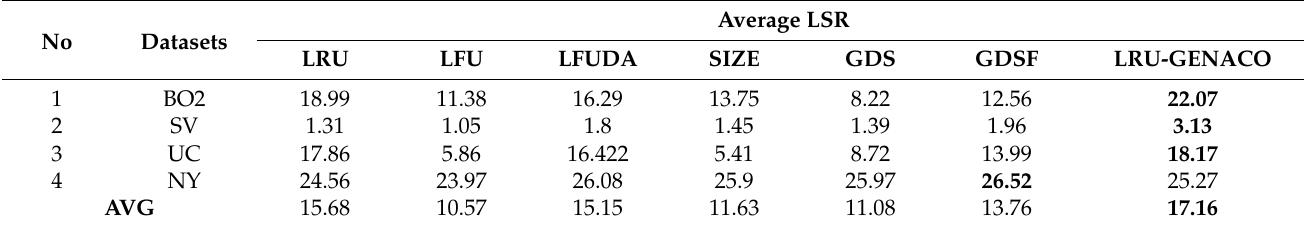
Table 3. LSR average comparison over conventional caching